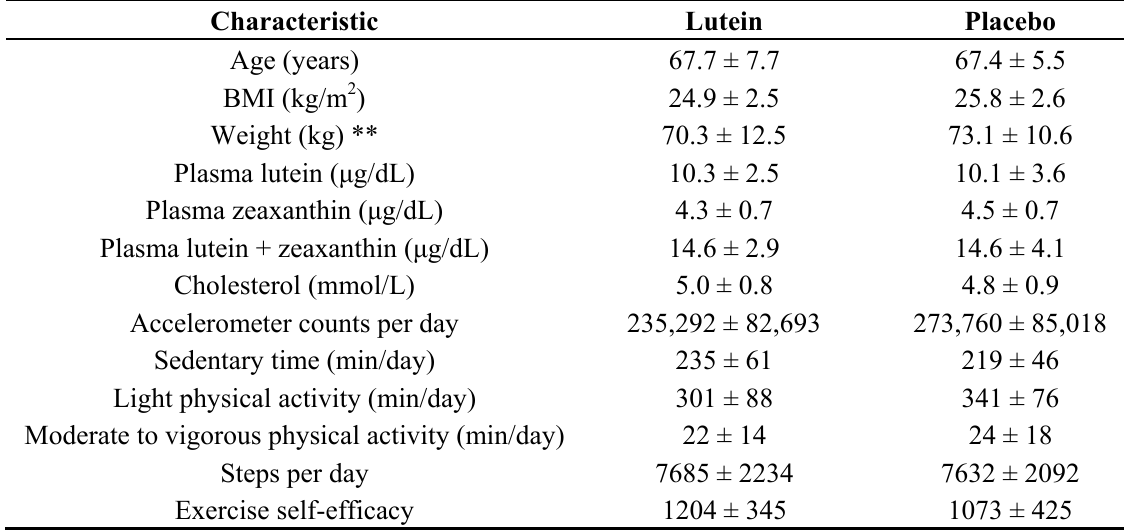
Table 1. Baseline characteristics for participants randomized to consume lutein or placebo capsules with